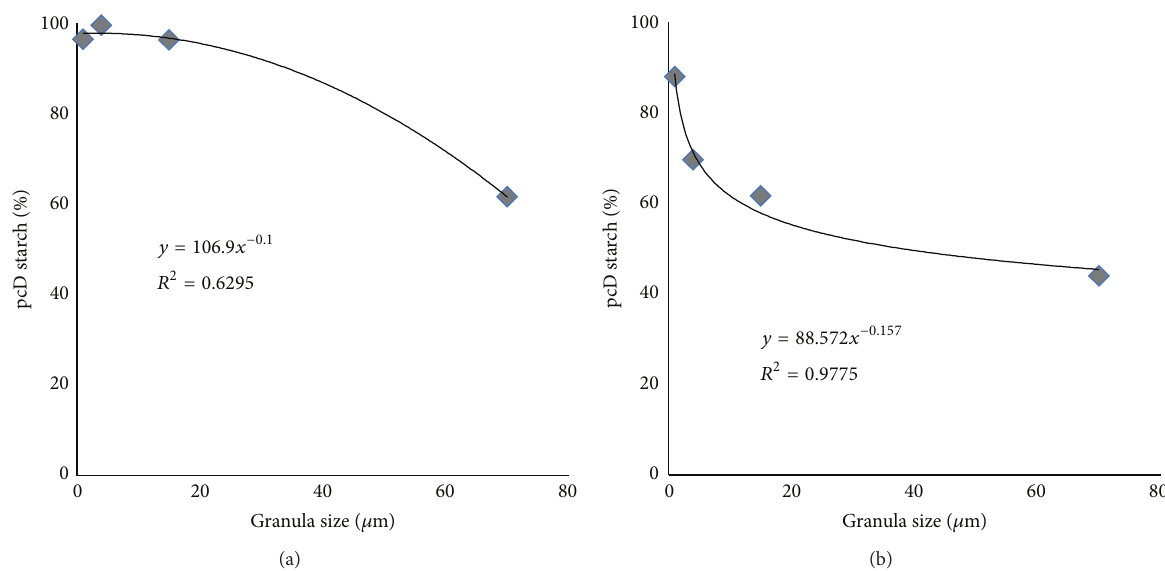
Figure 3: pcD of raw starch (%) in control-pigs (a) and PL-pigs (b) plotted against the granula size of the starch used (data taken from